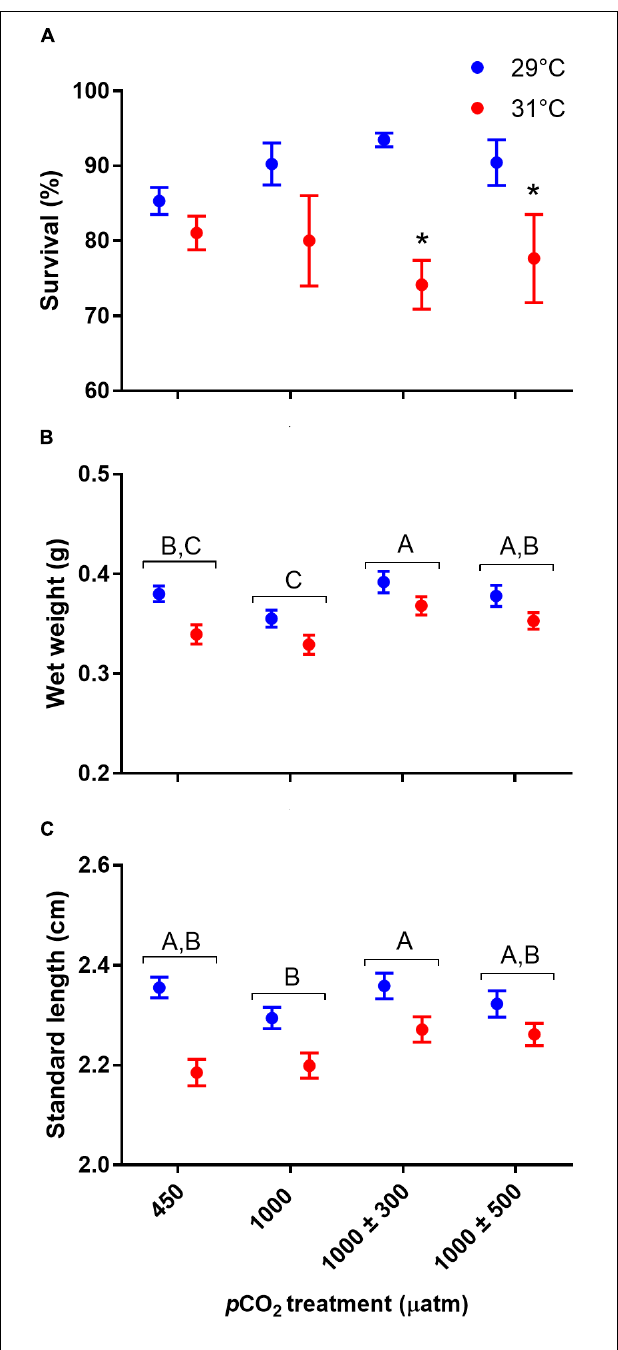
FIGURE 1 | Effects of elevated CO 2 and temperature on survival and growth of juvenile Acanthochromis polyacanthus. (A) Survival. (B) Wet weight. (C) Standard length. Different letters represent significant differences between p CO 2 treatments (Tukey’s, P < 0.05). Points represent means ± SE. ∗ Represent a significant difference between temperature treatments at the same p CO 2 level.